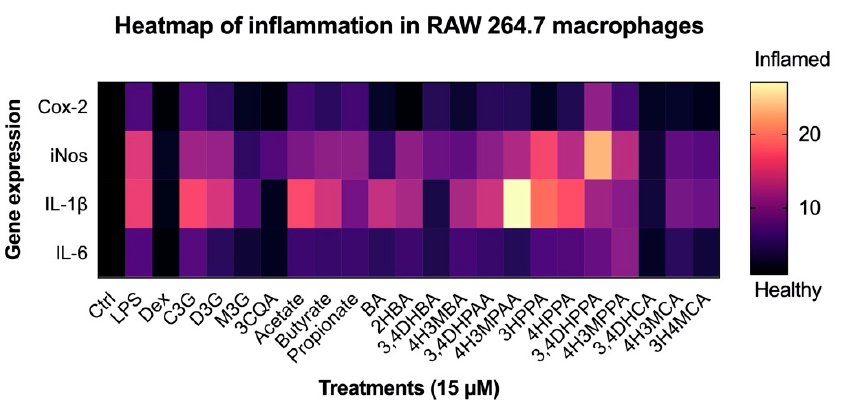
Figure 5. Heatmap of anti-inflammatory effects of wild blueberry anthocyanins, short-chain fatty acids, and phenolic acid metabolites based on qPCR gene expression profiles of key biomarkers of acute and chronic inflammation, including cyclooxygenase-2 (Cox-2), inducible nitric oxide synthase (iNOS), interleukin-1 β (IL-1 β ), and interleukin-6 (IL-6). Macrophages were pre-treated with individual compounds as the specified and inflammatory response was induced with 1 µg/mL LPS for 6 h. Dexamethasone (Dex) at 10 µM was used as a positive control. Total RNAs were isolated from duplicate treatments and pooled for qPCR analysis. Fold changes in gene expression are reported as means relative to healthy controls.